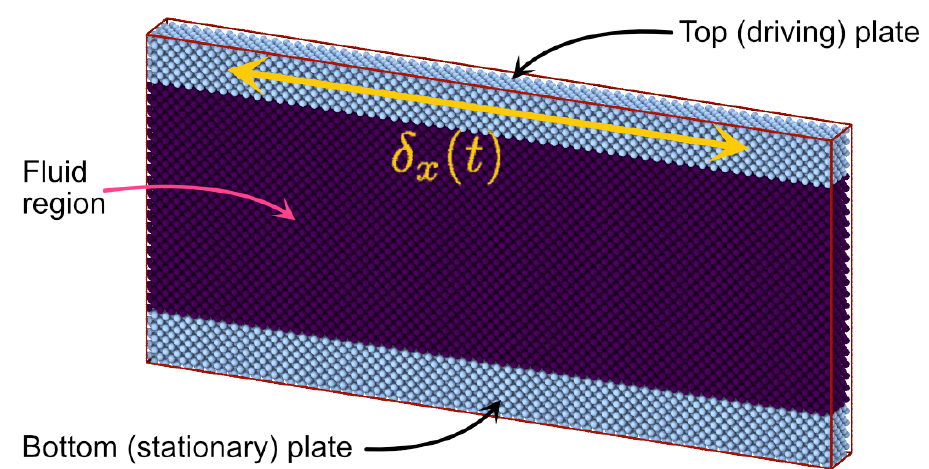
Figure 8. Configuration of oscillatory shear